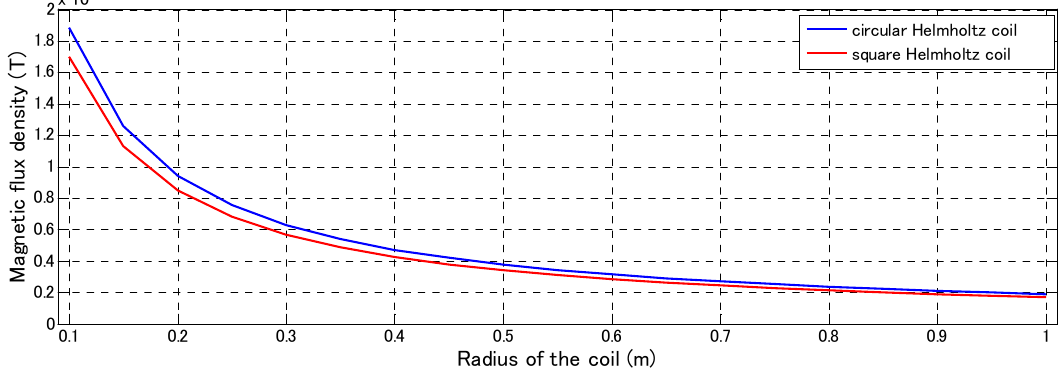
Figure 5. Simulation results of the magnetic flux density.